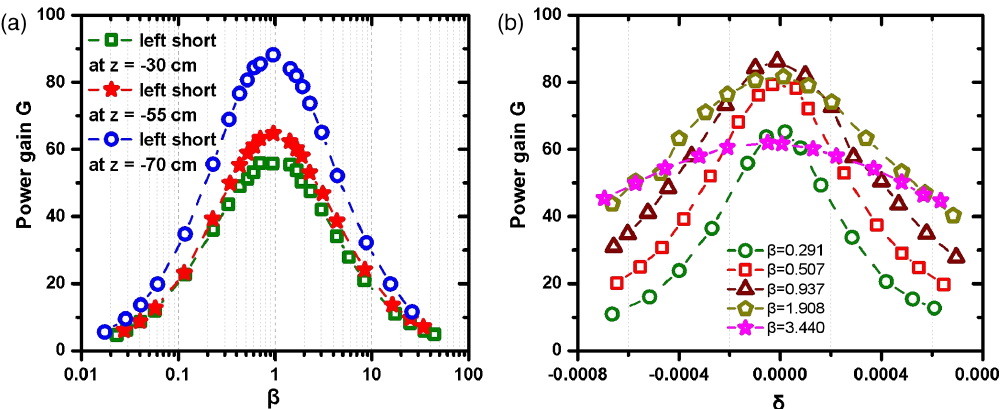
FIG. 19. The influences of the secondary coupler ’ s coupling factor β and the cavity ’ s detuning δ on the power gain of the proof-of- principle structure. (a) shows the influence of the coupling factor with the cavity detuning δ kept at 0; (b) presents the influence of the detuning δ under different β , with the left short at z ¼ − 70